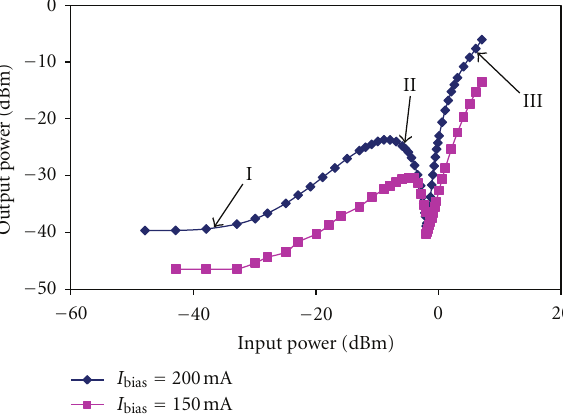
Figure 1: Experimental setup.